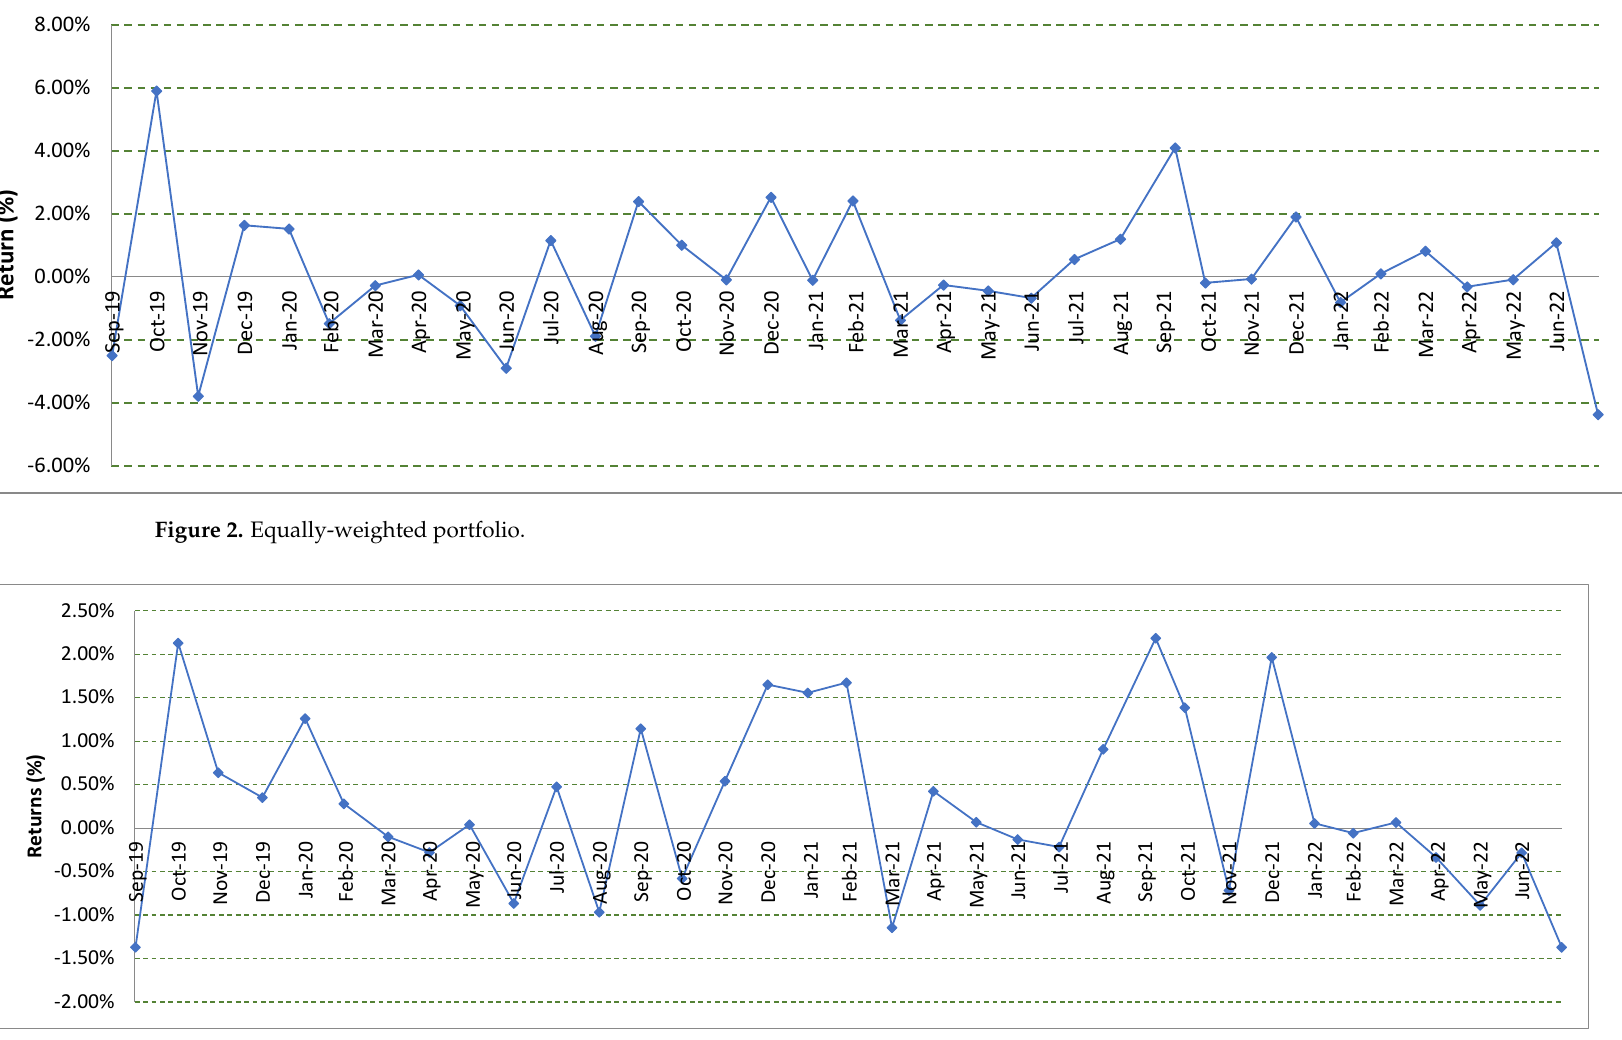
Figure 3. Mean-variance portfolio: long-only.